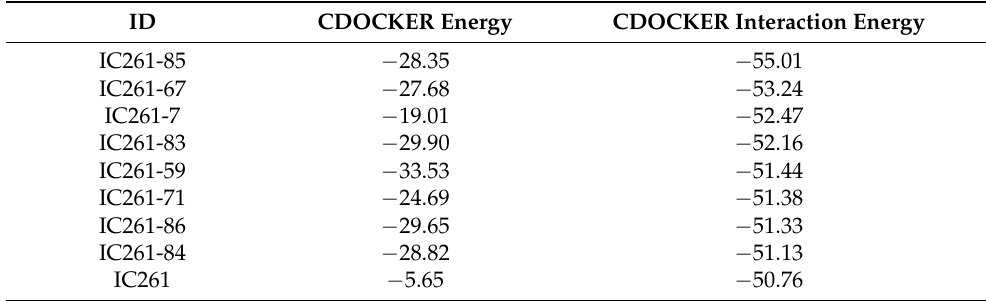
Table 2. Top eight ranked compounds with higher CDOCKER scores than IC261.